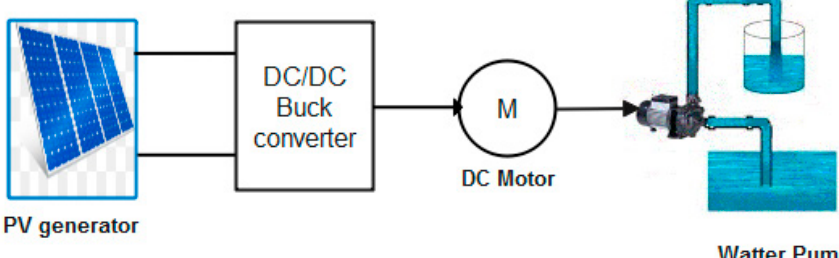
Figure 8. Photovoltaic system configuration.